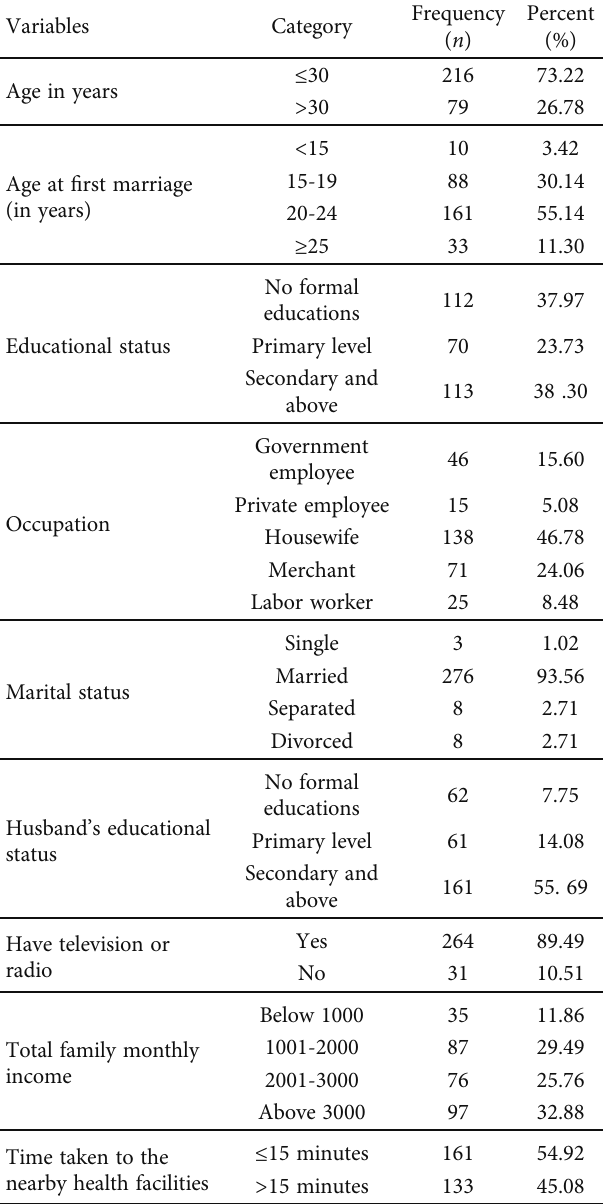
Table 2: Sociodemographic characteristics of the respondents in Debre Tabor town, Northwest Ethiopia, 2021.